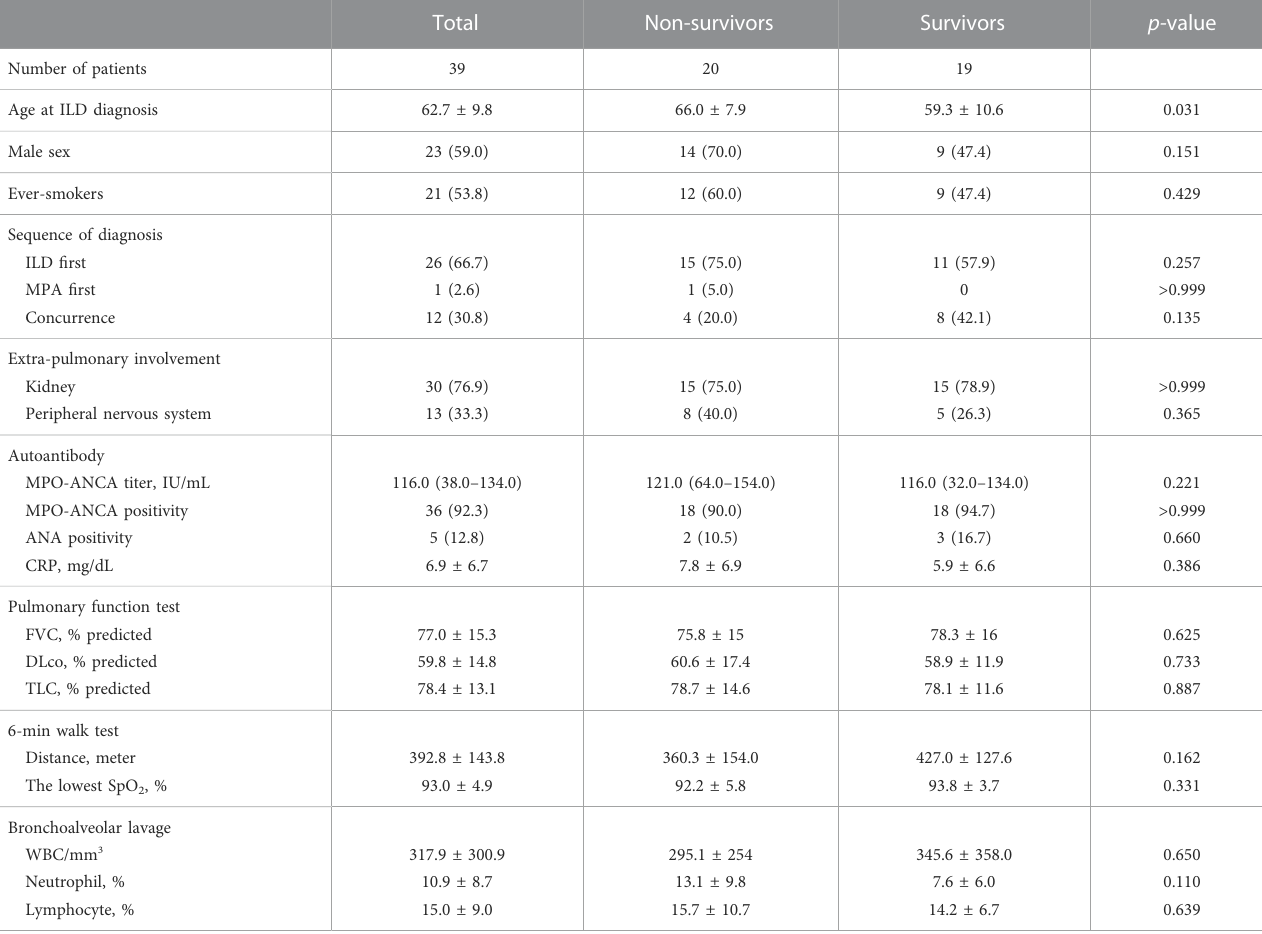
TABLE 1 Comparison of baseline characteristics between the non-survivors and survivors among patients with MPA-ILD.